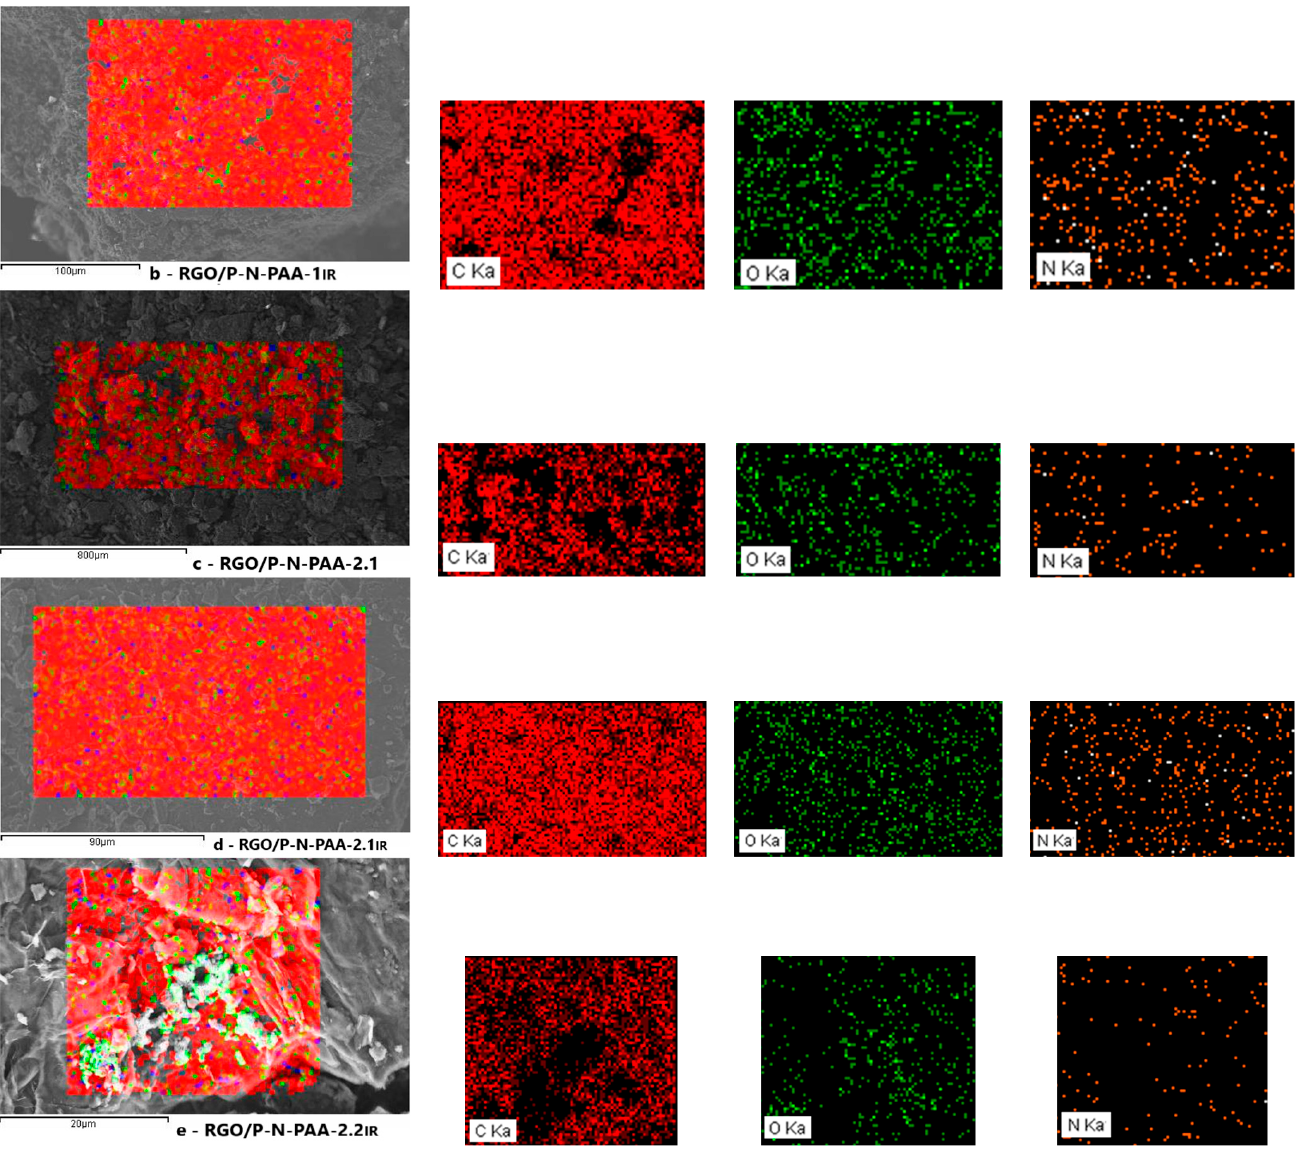
Figure 6. SEM-EDS mapping images of carbon C, nitrogen N, and oxygen O in RGO/P-N-PAA.